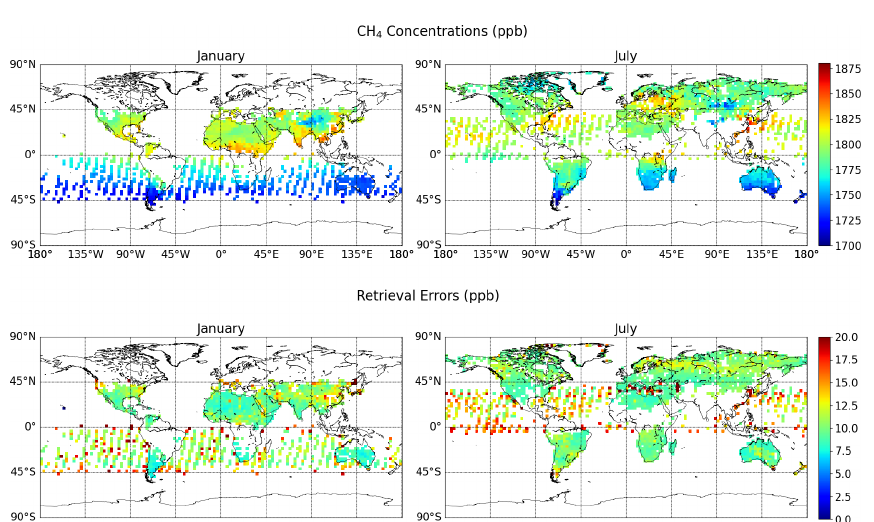
Figure 5. Same as Fig. 4 but for November 2010.